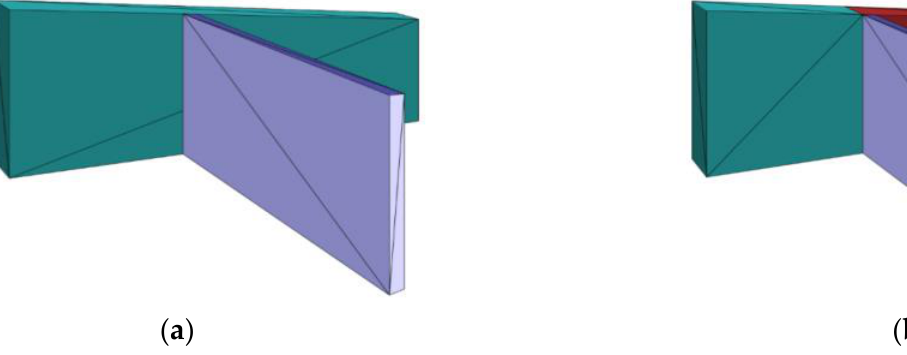
Figure 14. ( a ) Two meshes directly converted from the IFC input file; ( b ) Subdivided meshes according to IFC space objects for individual handling.